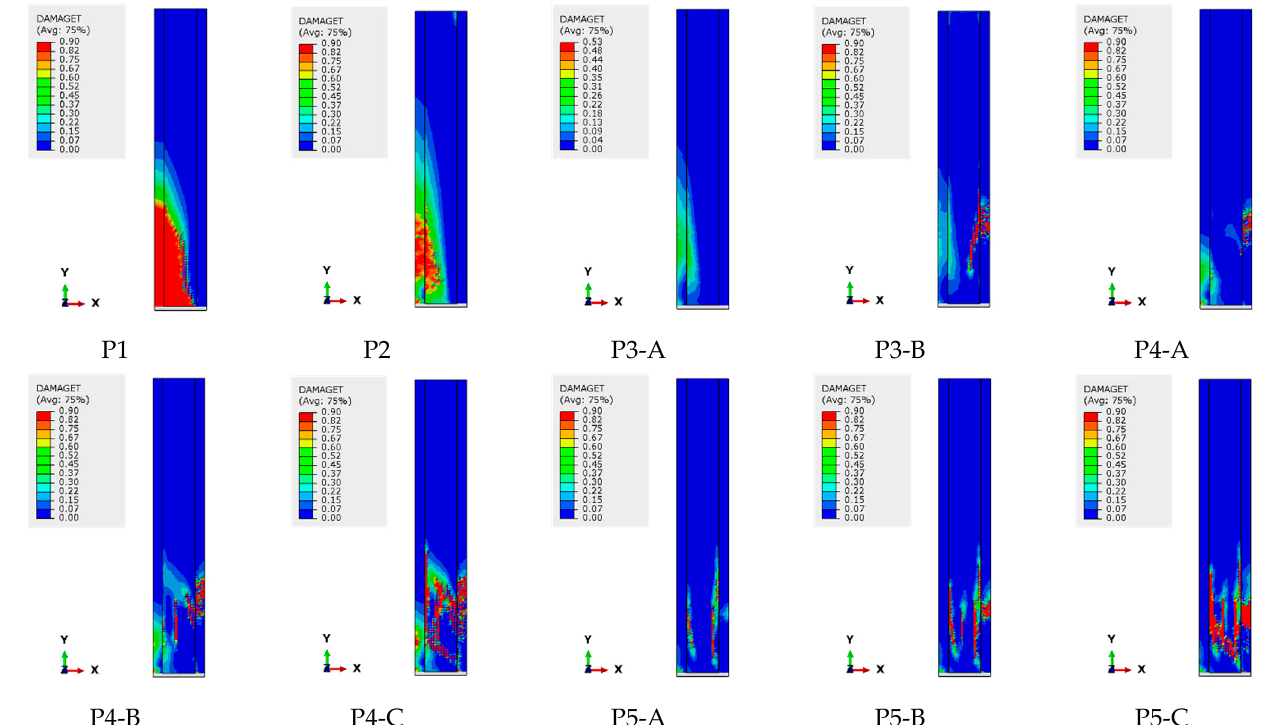
Figure B1. Pushover analyses results of T1-M1—Damage patterns.